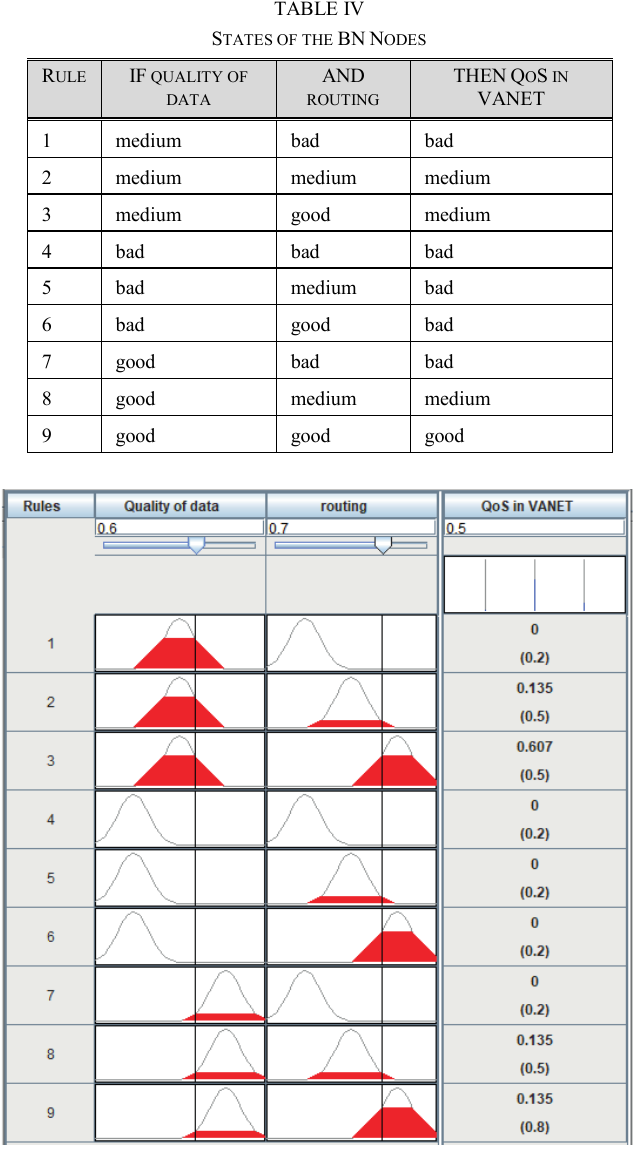
Fig. 4. Fuzzy inference of the ‘QoS in VANET’